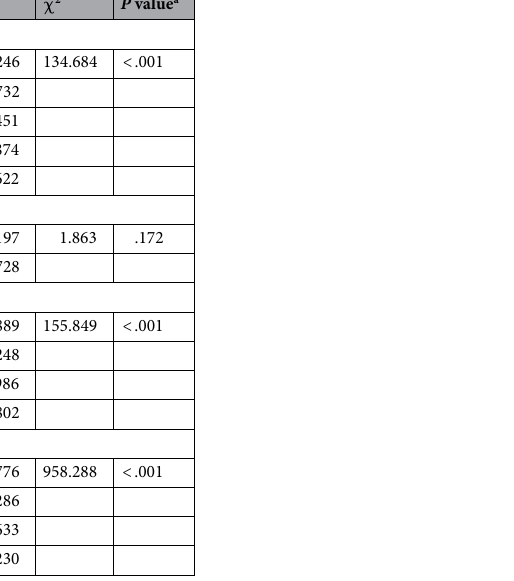
Table 1. Baseline characteristics of the study